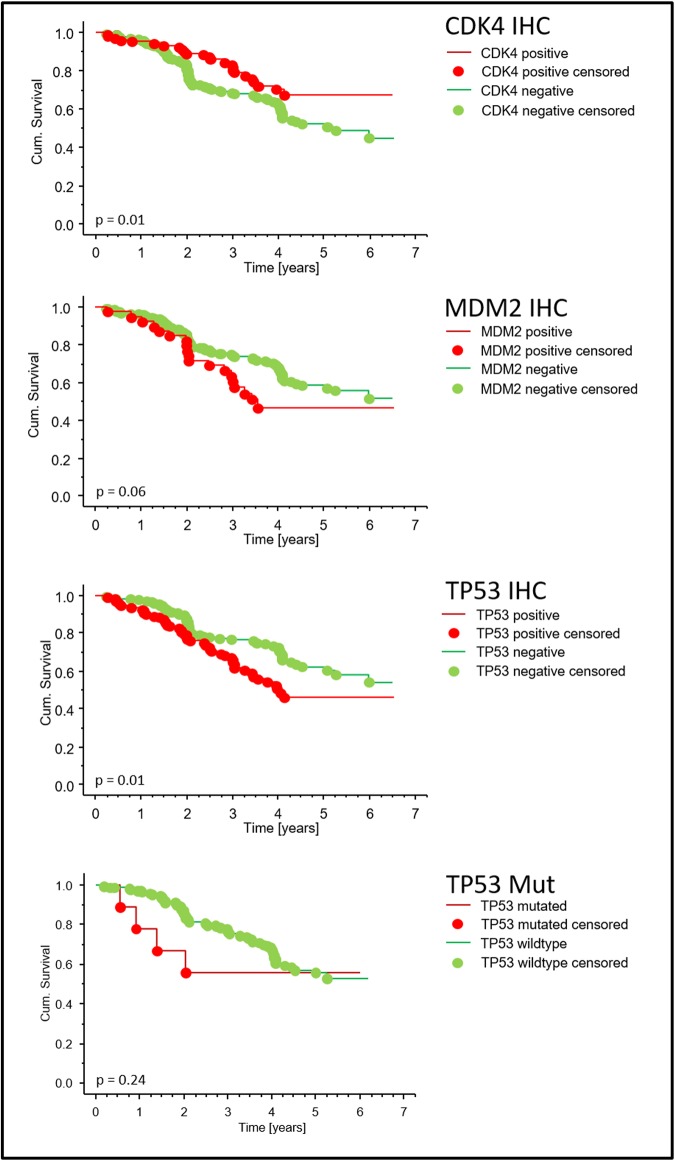
Recurrence free survival of patients with CDK4, MDM2 and p53 expression or TP53 mutated tumors.Kaplan-Meier survival curve showing analysis of recurrence free survival in patients from the SSGXVIII study. A high expression of CDK4 is positively correlated with recurrence free survival (red line, p = 0.01) in contrast to a high expression of MDM2 and p53 (TP53, red line, p = 0.06 and p = 0.01, respectively, log-rank test). TP53 mutations tend to correlate to a worse recurrence free survival but did not reach significant levels due to a small number of mutated tumors (p = 0.24, log-rank test).